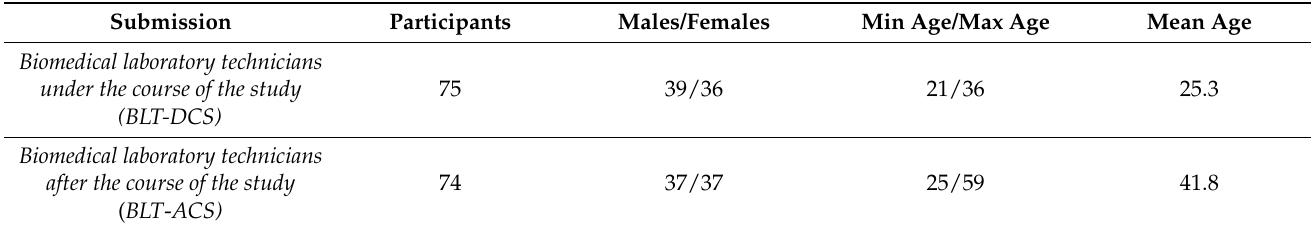
Figure 1. The CONSORT diagram. Table 1. Characteristics of the admitted to the study the DCS and the ACS.